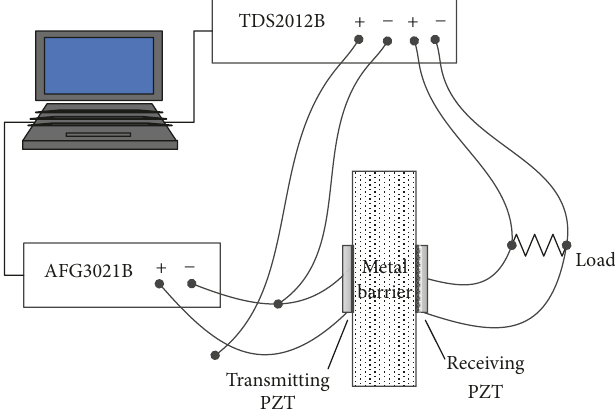
Figure 9: Scheme of the output-to-input voltage transfer ratio measurement of the